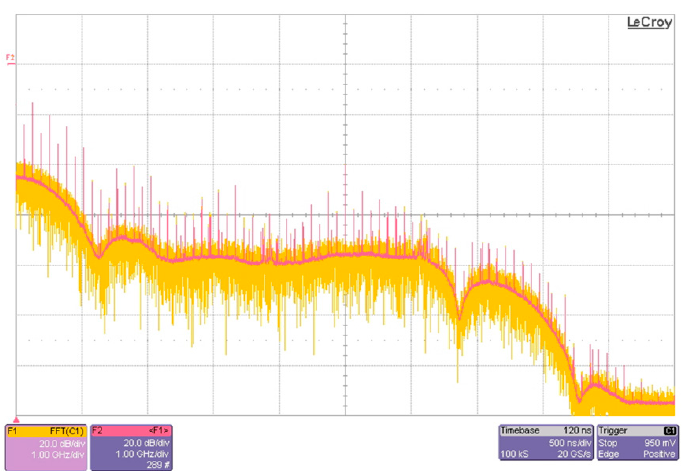
Figure 7. Power spectrum of the transmitted pulsed signal U T ( t ) (orange trace) and its average value (purple trace). Table 1. Main performances of different biotelemetry links.